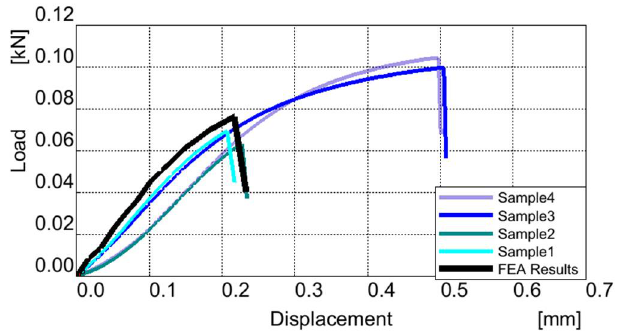
Figure 5. Comparison of experimental and numerical (FE) load-displacement curve of jelly roll sam- ples.